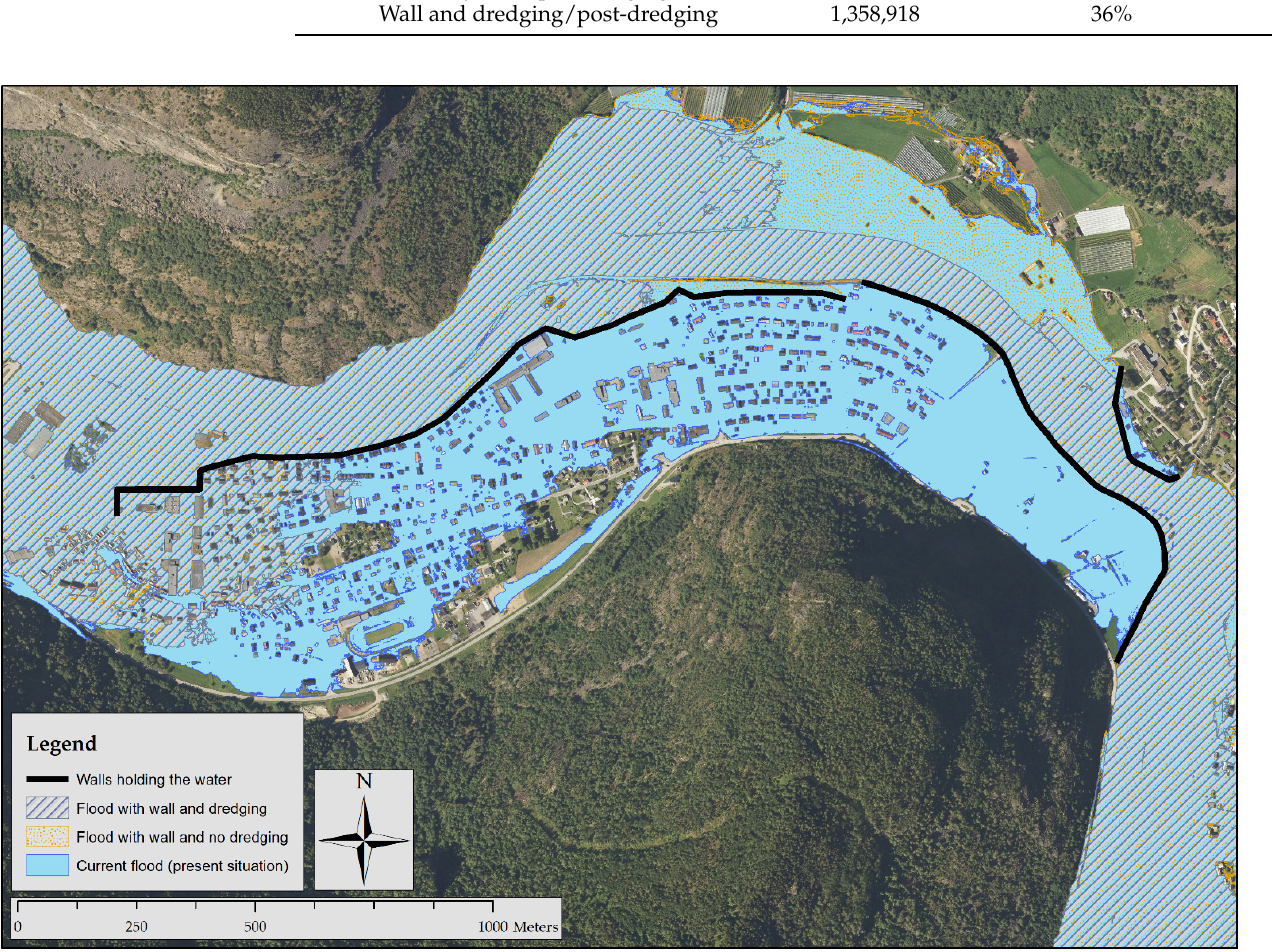
Figure 5. Flooded area at current situation (blue), with wall and no dredging (dotted) and with wall and dredging (stripes) with discharge 920 m 3 /s.